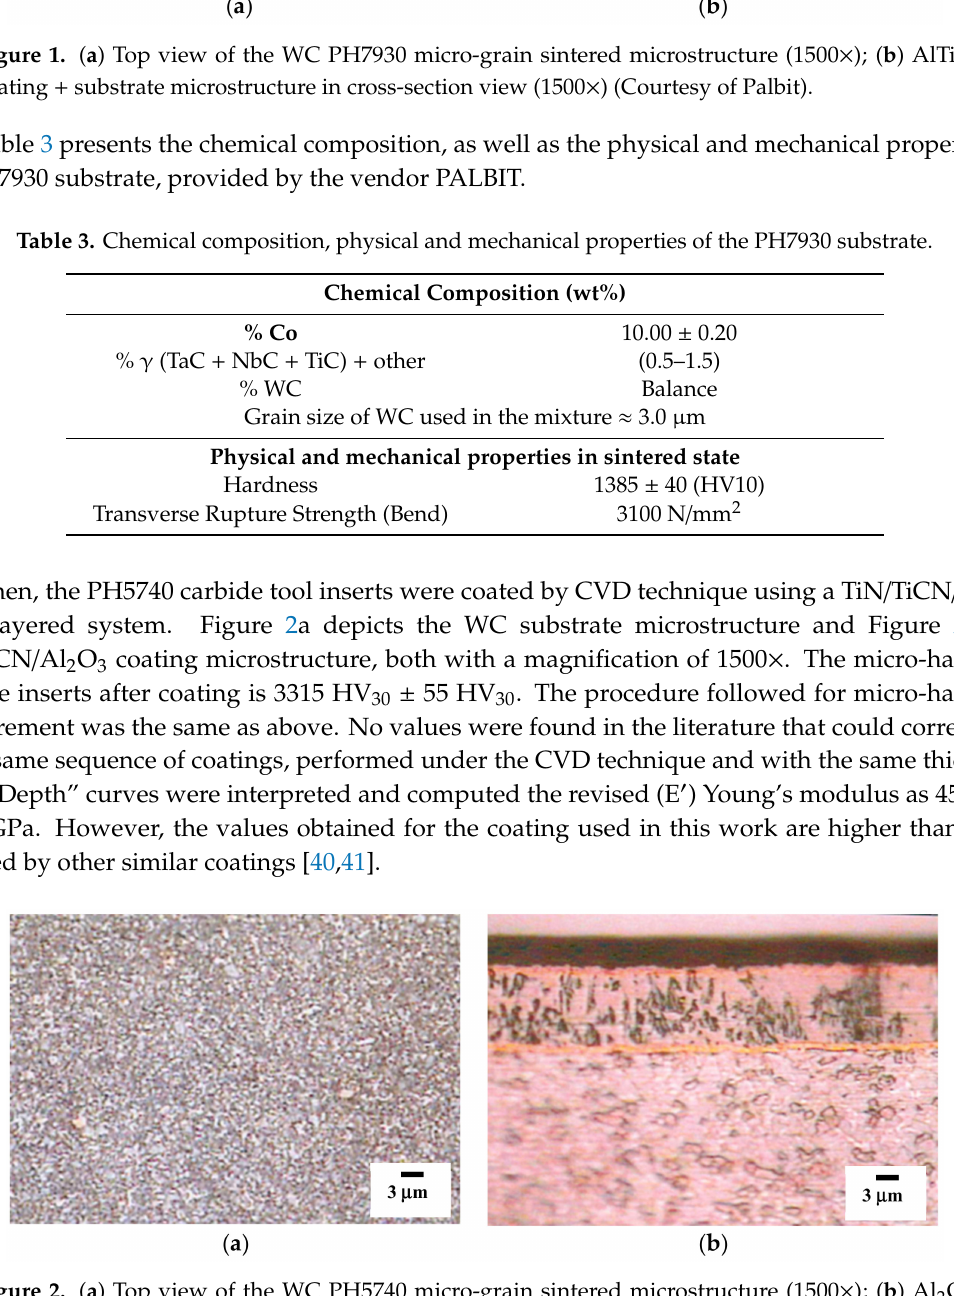
Figure 2. ( a ) Top view of the WC PH5740 micro-grain sintered microstructure (1500 × ); ( b ) Al 2 O 3 coating + substrate microstructure in cross-section view (1500 × ) (Courtesy of